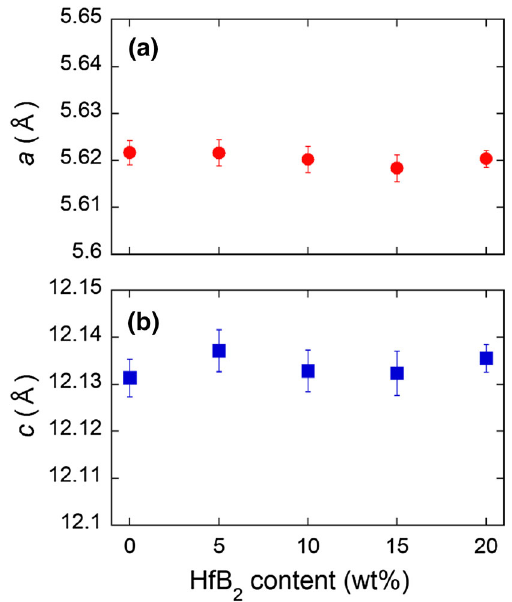
Fig. 2 Effect of the HfB 2 content on the lattice parameters of boron carbide